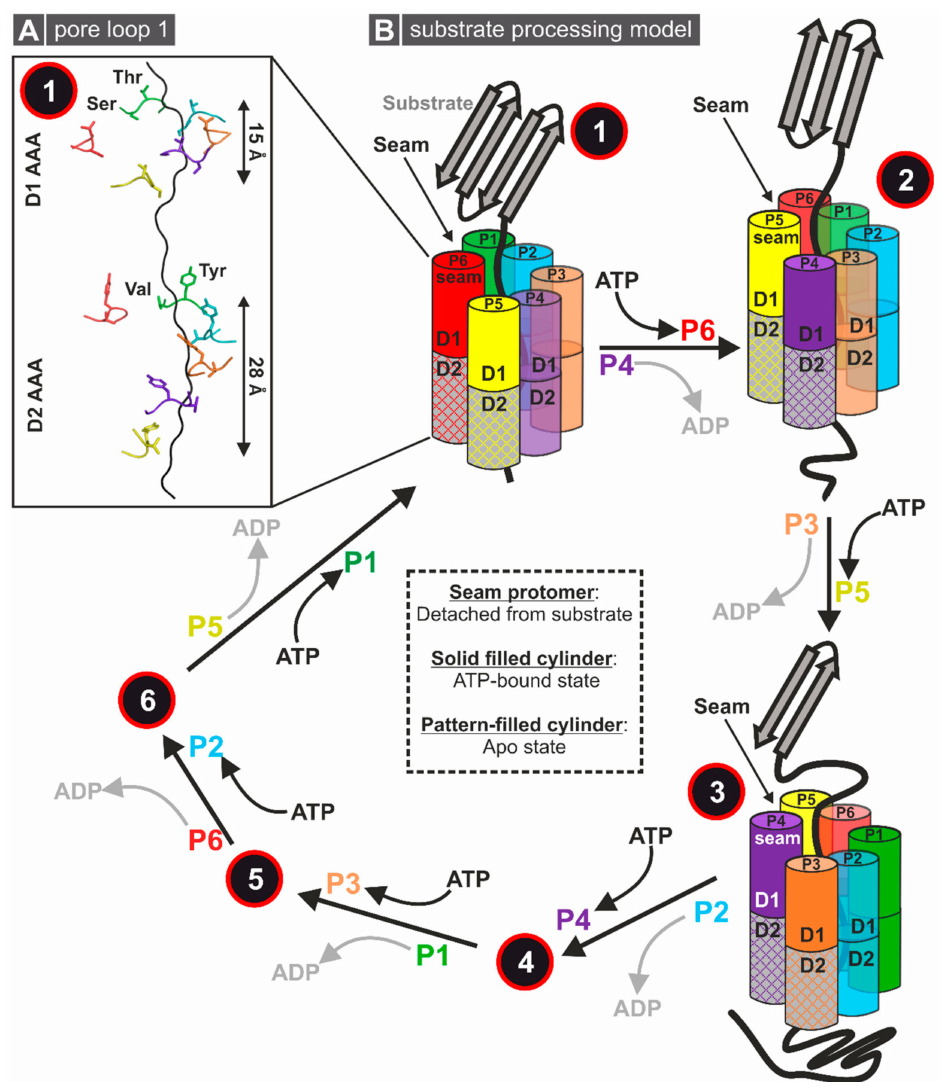
Figure 5. Working model for substrate translocation by Rix7. ( A ) Positions of pore loops 1 (PL-I) surrounding the bound substrate (threaded polypeptide, black cartoon). Individual protomers